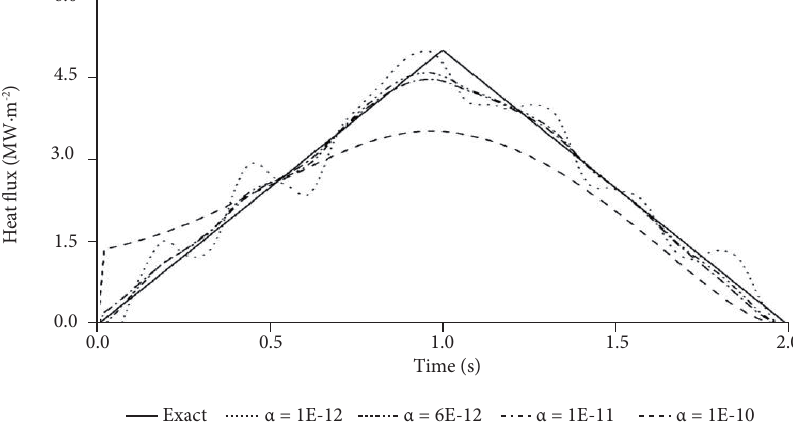
Figure 4. Effect of the regularization parameter α on the stability of inverse